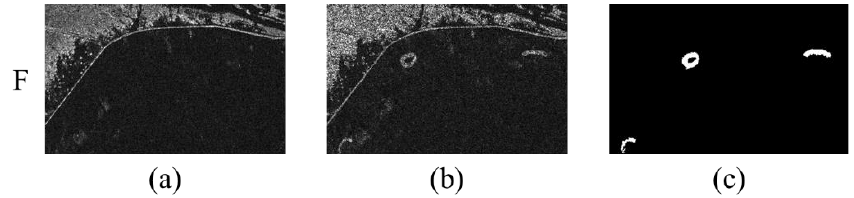
Figure 10. Yellow River C Dataset. ( a ) Image acquired in June 2008. ( b ) Image acquired in June 2009. ( c ) Ground-truth map.